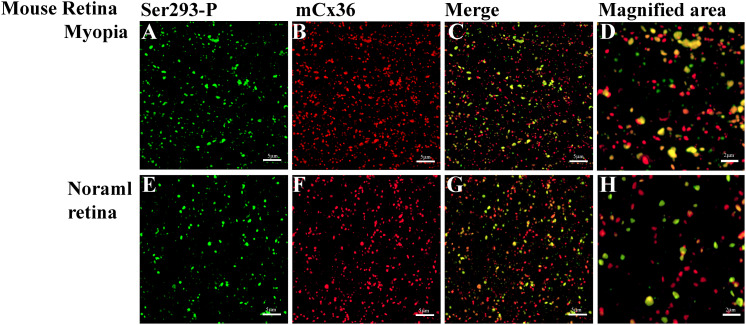
Phospho-Ser293 antibodies specifically recognizes Cx36 in the whole mount mouse retina. (A–D) Confocal stack sections in stratum 5 of the IPL of the myopic mouse retina: mCx36 labeled in red and its phosphorylated form, Ser293-P (green), are present with similar punctate labeling. The magnified areas show the merged images of phosphorylated Cx36, reflected by yellow color. (E–H) Phospho-Ser293 antibody recognizes Cx36 in the control mouse retina. Images are 2-μm deep stacks. Scale bar: (A–C,E–G) 5 μm, (D,H) 2 μm.